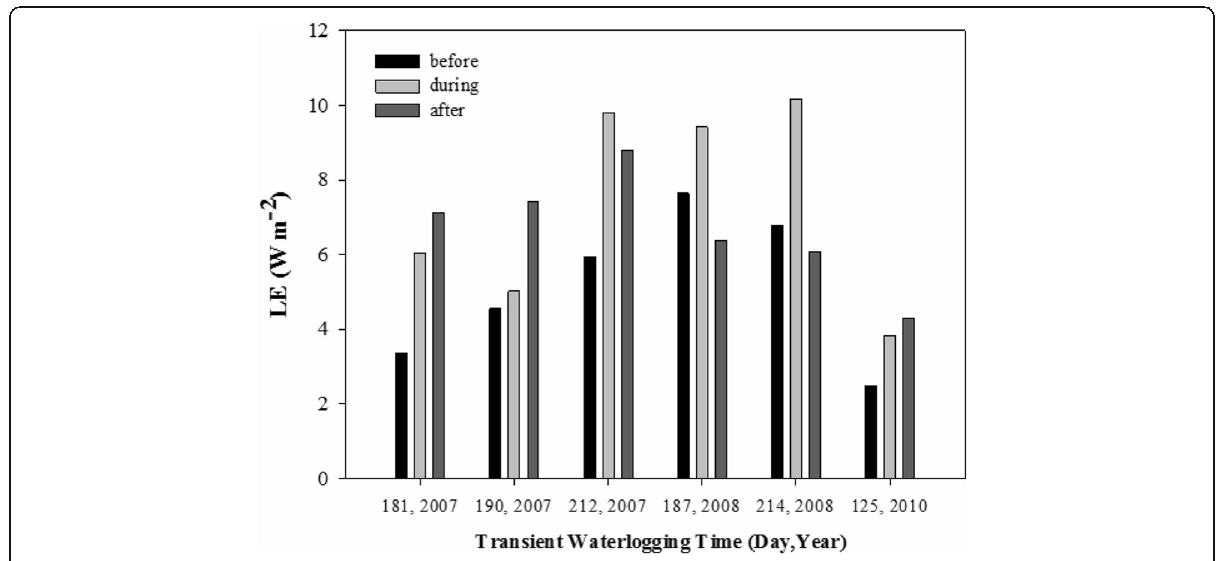
Fig. 8 The magnitudes of latent heat (LE) before, during (3-day), and after the transient waterlogging during 2007 –